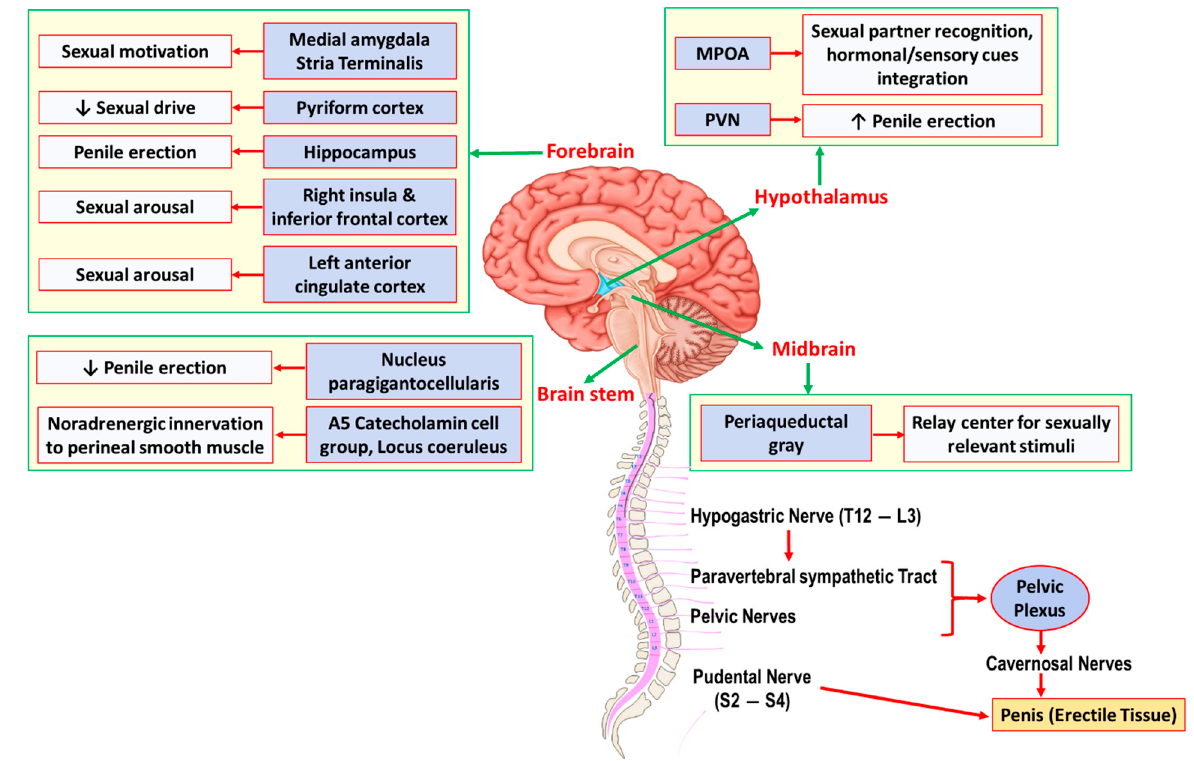
Figure 1. Schematic representation of central and peripheral neural pathways controlling the penile erection. Several brain regions including forebrain, midbrain, hypothalamus, and brainstem are involved in sexual drive, arousal, and ultimately erectile function. Sexual stimuli activate brain regions through which they stimulate the hypothalamus and its nuclei (mainly medial preoptic area [MPOA] and paraventricular nucleus [PVN]). The neural pathway then traverses through the medulla oblongata and the spinal cord to the genital apparatus, i.e., penile tissue in males. Two major nerves innervating the penis include (i) the Pudental nerve, which arises from sacral S2–S4 roots and contains the primary afferent sensory and efferent motor pathway to the penis, and (ii) the Cavernosal nerves, which contain the primary efferent sympathetic and parasympathetic pathways originating from the pelvic plexuses. Three nerve groups also innervate pelvic plexuses: (i) the hypogastric nerve (from T12–L3 nerve roots), (ii) pelvic nerves (from sacral nerve roots), and (iii) the post ‐ ganglionic fibers from the paravertebral sympathetic thoracolumbar (T12–L3 levels) ganglia chain.